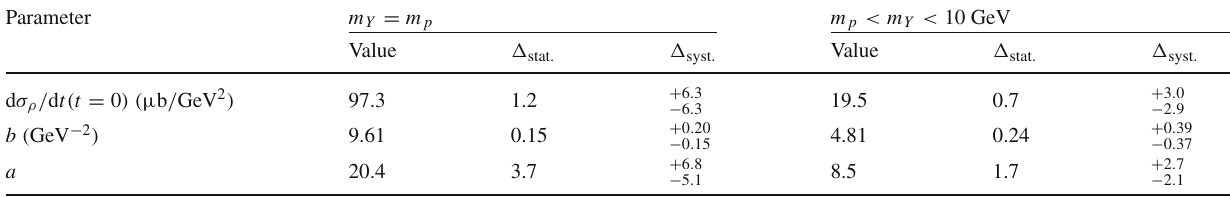
Table 11 Fit parameters for the fit of the t dependencies of the elas- atic uncertainties are given. A full uncertainty breakdown and statistical tic and proton-dissociative ρ 0 meson photoproduction cross sections correlations are provided [77]. The corresponding fit is shown in Fig. 14 d σ(γ p → ρ 0 Y )/ d t . The nominal fit values and statistical and system- Parameter m Y = m p m p < m Y < 10 GeV Value (cid:20)